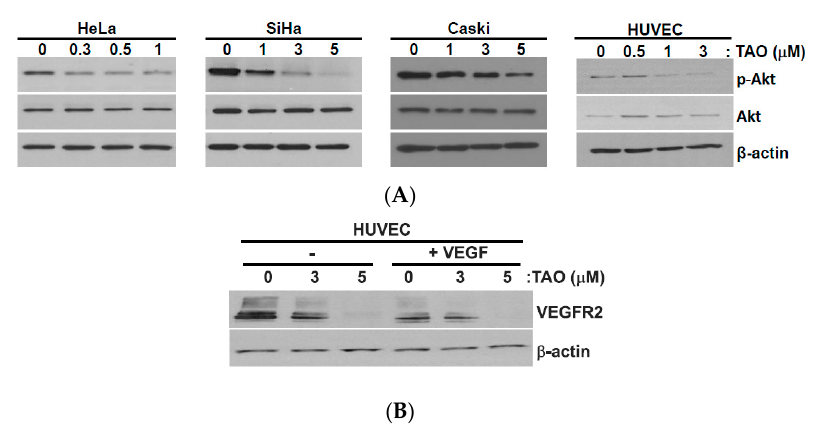
Figure 3. ( A ) Western blot analysis of Akt and phosphorylated-Akt (p-Akt) in the cell lines 48 h after the treatment of TAO with varying concentrations. The treatment of TAO decreases the phosphorylation of Akt. ( B ) Western blot analysis of vascular endothelial growth factor receptor 2 (VEGFR2), demonstrating that the treatment of TAO in HUVECs results in decreased concentration of VEGFR2. The same pattern of observation is seen in HUVEC, both with and without the treatment by vascular endothelial growth factor (VEGF).